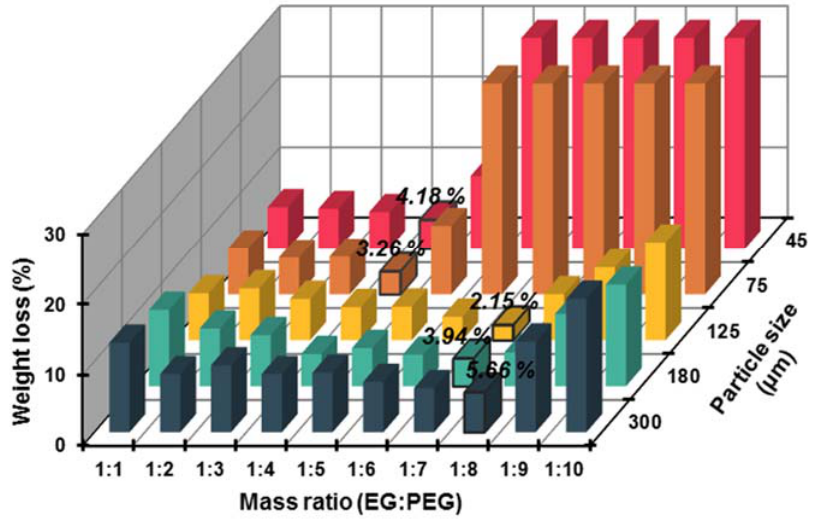
Figure 2. Weight loss of different EG/PEG composite phase change materials (EPs) after heat treatment.